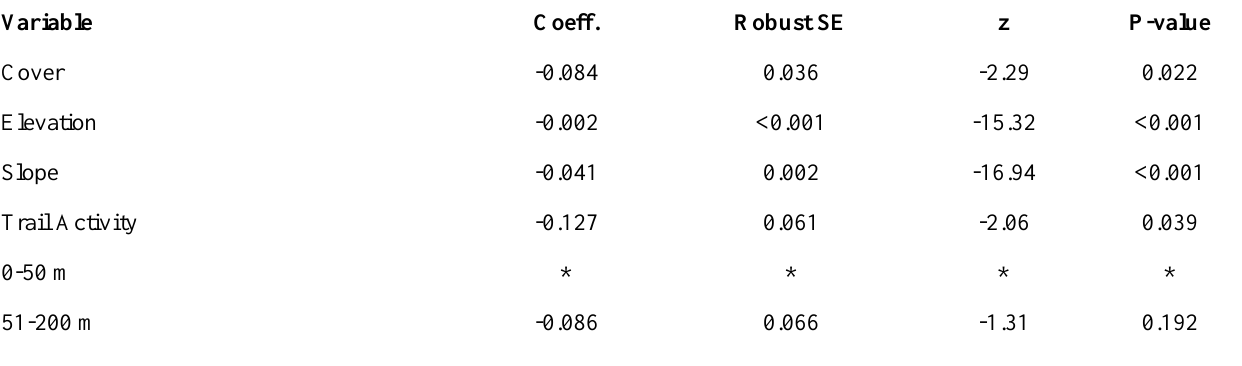
Table A1.5 . Model results for wolves on trails. Results predict wolf occurrence near trails using matched case-control logistic regression and 0-50 m as the reference category.